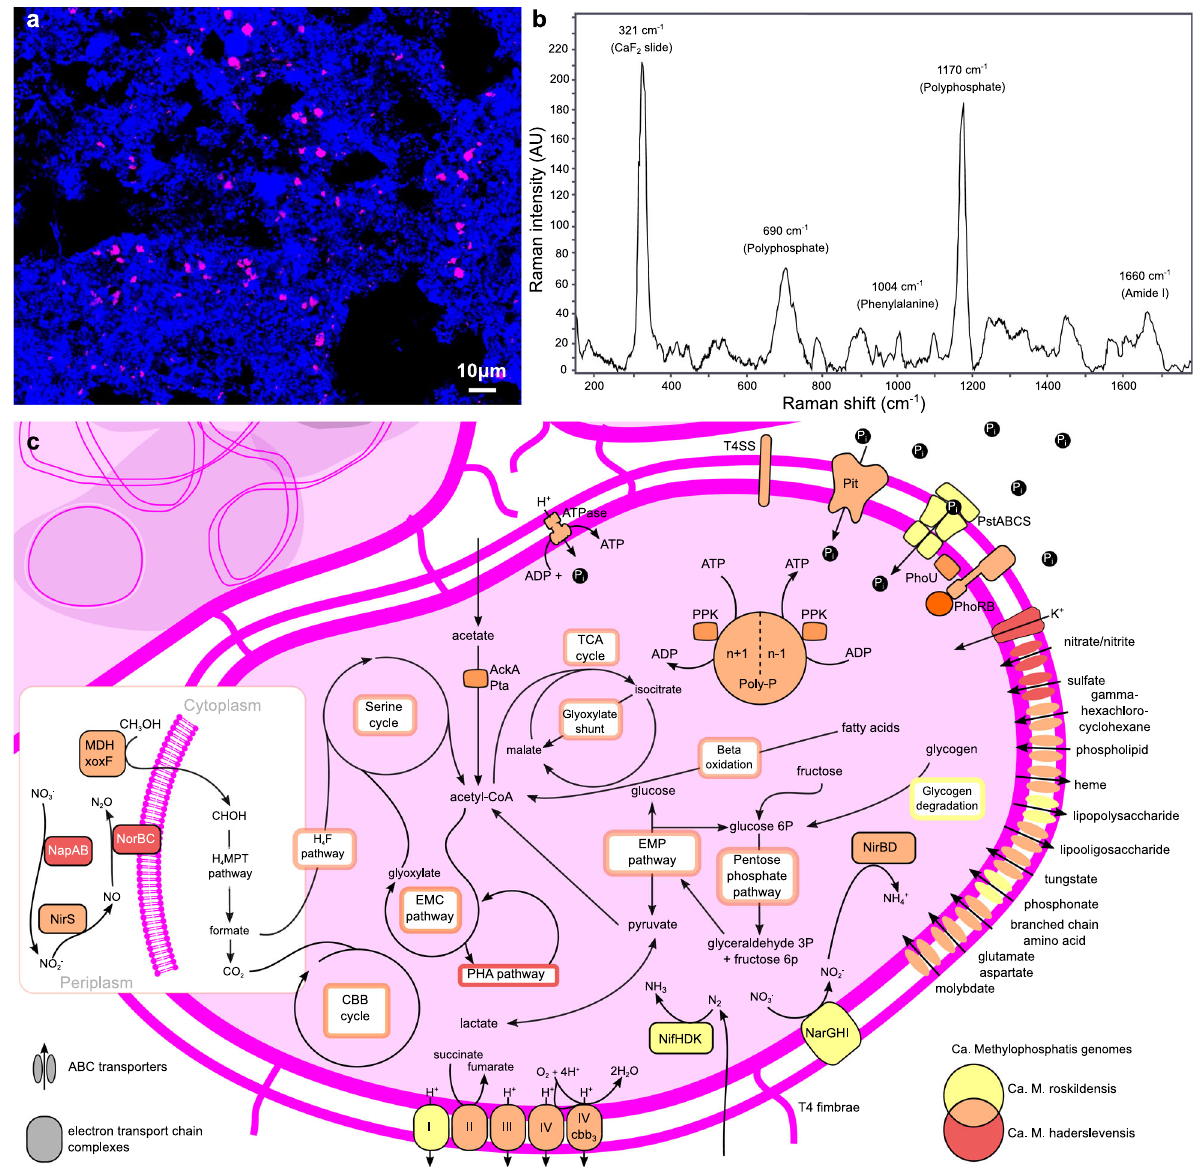
Fig. 5 Overview of Ca . Methylophosphatis based on FISH, Raman microspectroscopy, and metabolic reconstruction. a FISH micrograph of Ca . Methylophosphatis, targeted by the genus-speci fi c probe g190_1276 (Cy3-labeled) in a full-scale activated sludge sample from Bjergmarken WWTP (2018-08-29). Two samples were examined in total and multiple images were recorded for each sample. Source data are provided as a Source Data fi le. Target cells appear magenta, whereas all other bacterial cells appear blue. Scale bar represents 10 μ m. b Raman spectrum of Ca . Methylophosphatis (average of 100 FISH-de fi ned cells) showing the presence of the signature peaks for polyphosphate (690 and 1170 cm − 1 ). Peaks for phenylalanine (1004 cm − 1 ) and amide I linkages of proteins (1450 cm − 1 ) are speci fi c markers for biological material. AU, arbitrary units. c Metabolic reconstruction of the Ca . Methylophosphatis MAGs. Colors represent the species or combination of species (Venn diagram) that encode the potential for the enzyme or